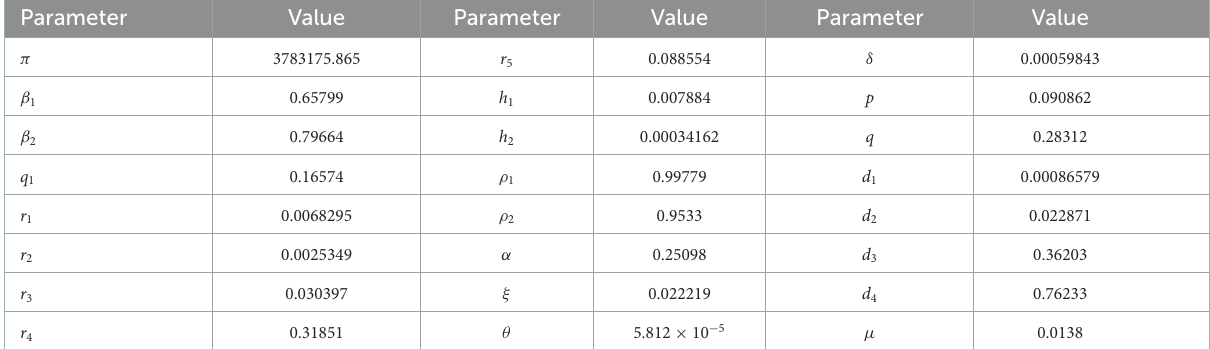
TABLE 1 Parameter values according to the fitting of the infected cases of COVID-19 in Indonesia.